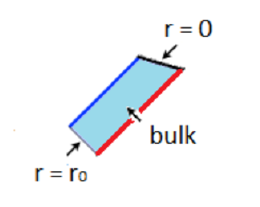
Figure 7 . Asymptotic contributions for the non-rotating case.